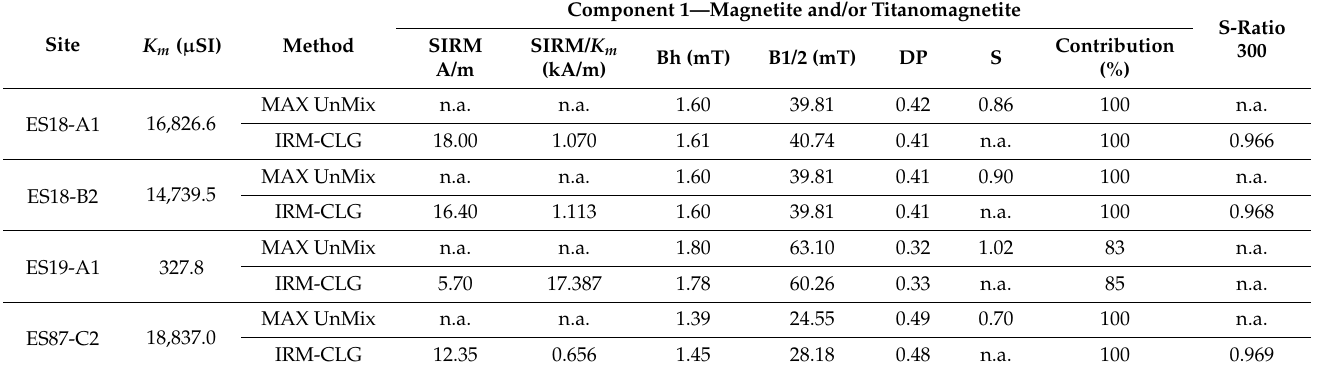
Table 1. Isothermal remanent magnetization data from the first component of the studied samples. The Cumulative log-Gaussian (CLG) treatment allows the definition for each magnetic component: K m : magnetic susceptibility; SIRM: saturation of isothermal remanent magnetization; Bh: coercivity (log(B1/2)); B1/2: field at which half of the SIRM was reached; DP: dispersion parameter; S: skewness.